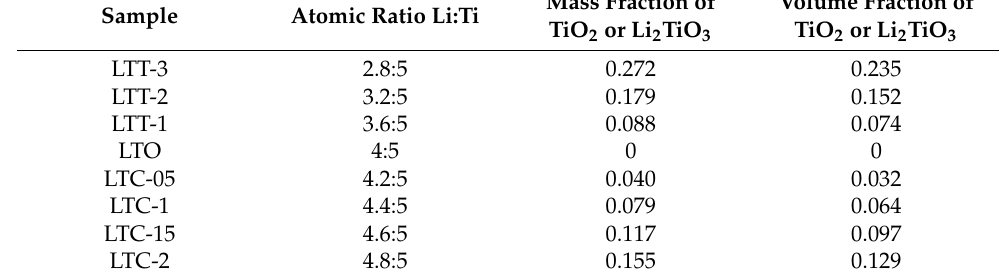
Table 1. The calculated values of relative concentrations of components in composites.